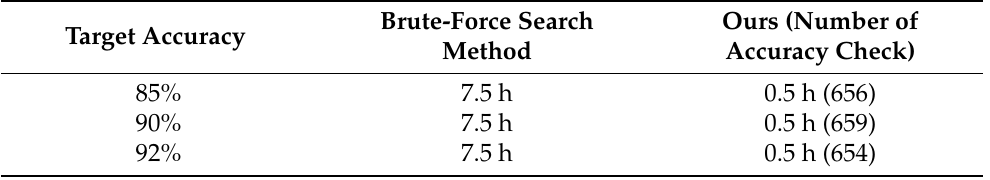
Table 7. The execution times in the corresponding accuracies derived from the proposed method and the individual cases of network slimming and deep compression for